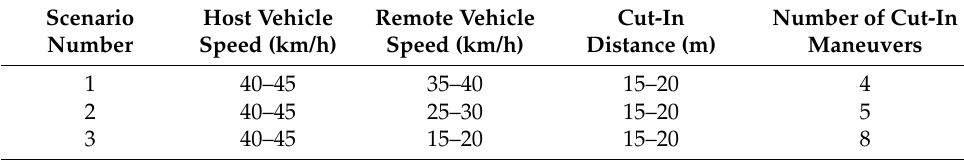
Table 11. Cut-in driving scenario descriptions.